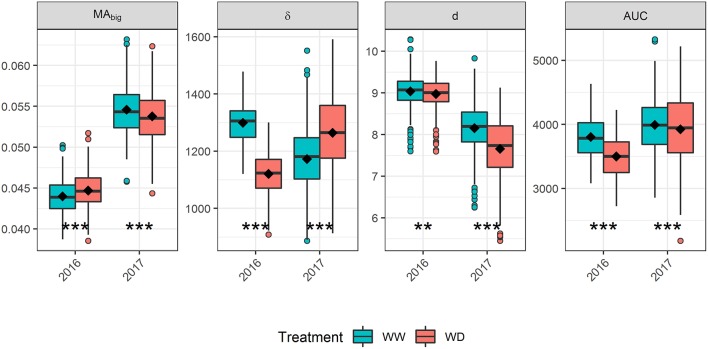
Impact of drought stress on the biggest leaf area (MAbig), leaf longevity (δ), density (d) and the Area Under the Curve (AUC) in 2016 and 2017. Boxplots are built from adjusted means. The horizontal line in the boxplots corresponds to the median, while the diamond corresponds to the mean. The lower and upper hinges show the first and third quartiles, and the whiskers correspond to 1.5 times the inter-quartile range or to the most extreme value, whichever is smallest. Dots represent values outside this range. Asterisks indicate a significant difference of means between treatments based on a paired t-test: ***
p ≤ 0.001; **
p ≤ 0.01.